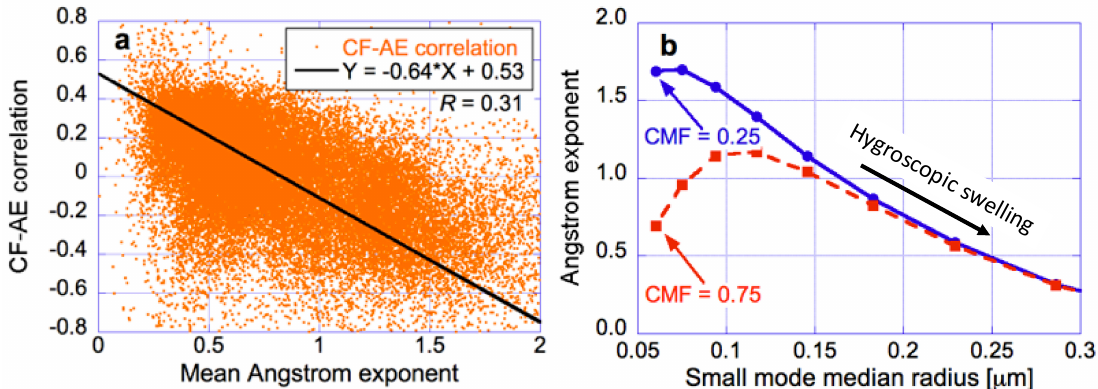
Figure 13. Observations ( a ) and simulations ( b ) showing the impact of coarse mode fraction (CMF) on the way AE changes with CF. ( a ) MODIS Dark Target aerosol data, showing the relationship between the June–July–August mean AE of 1° by 1° oceanic regions, and the correlation between the daily mean CF and AE values for the same regions. ( b ) Mie calculations showing how the AE of bimodal aerosol populations changes as small-mode particles undergo hygroscopic swelling while coarse mode particles remain unchanged. This panel shows the changes in AE for two populations with pre-swelling CMFs of 0.25 and 0.75, respectively. (As small-mode particles swell, CMF decreases.) The figure is based on Figure 8 of [42].